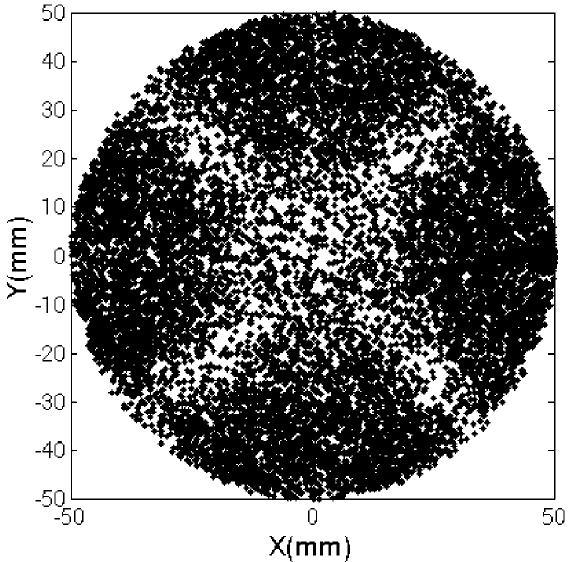
FIG. 5. Electron-cloud distribution in the C-yoke quadrupole with equal polarity